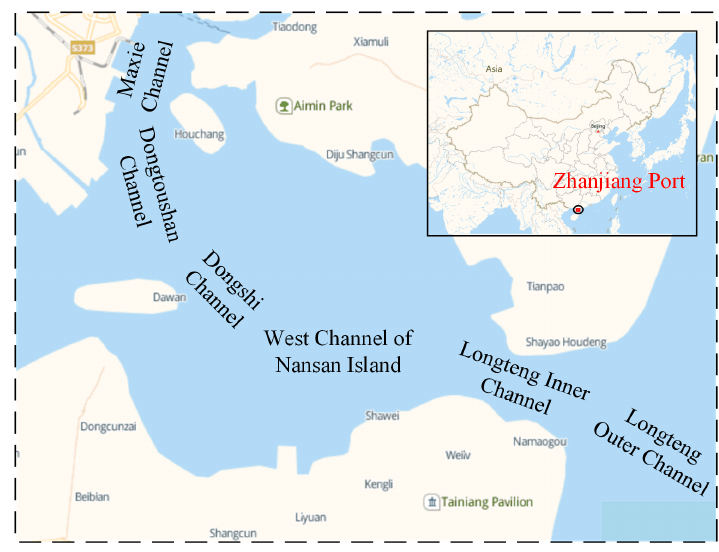
Figure 6. The research area in Zhanjiang